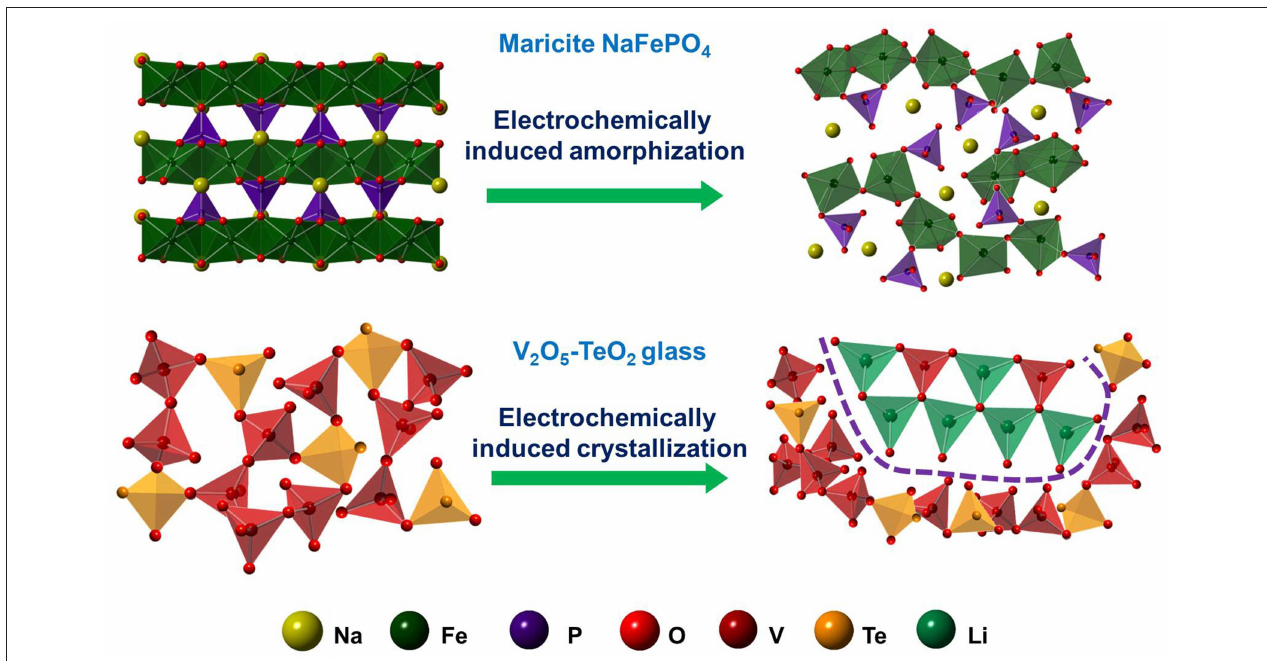
FIGURE 2 | Schematic diagram of structural evolution of electrochemically induced amorphization (maricite-type phase NaFePO 4 as an example) or crystallization (V 2 O 5 -TeO 2 glass as an